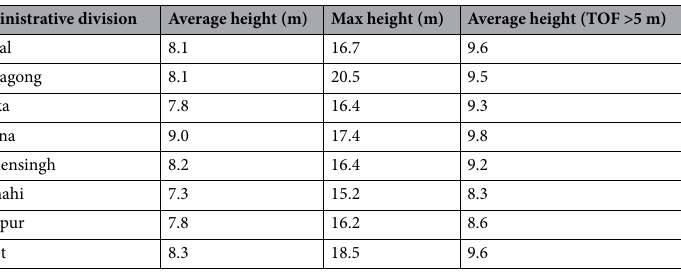
Table 4. Average and maximum TOF heights per division in Bangladesh, with average tree height for trees above 5 m only.